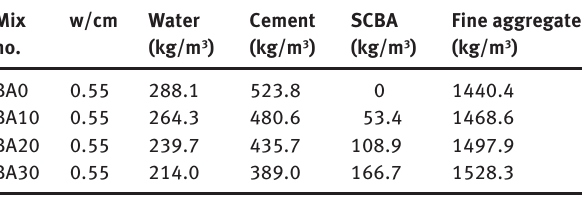
Table 2 Mix proportions of SCBA-blended mortars.